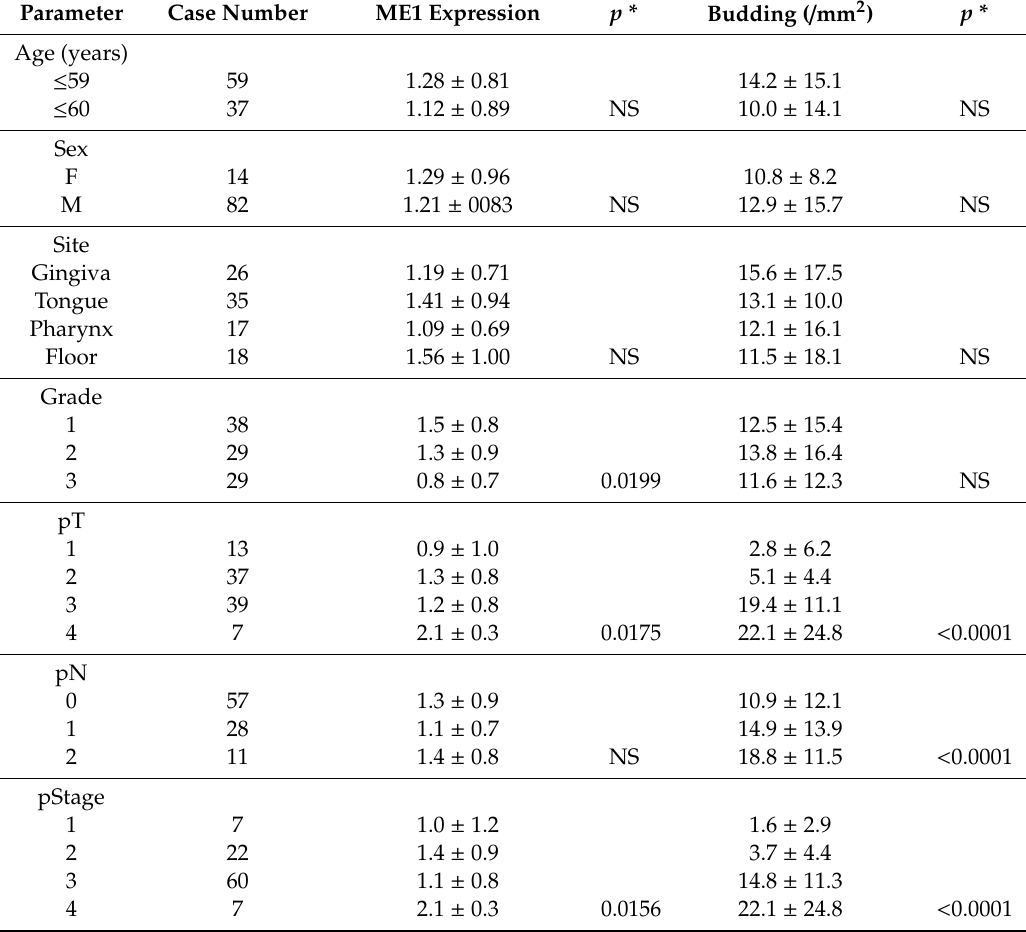
Figure 1. Relationship between tumor budding and malic enzyme)1 expression. ( A ) Tumor budding confirmed by AE1/AE3 immunostaining and ME1 immunoreactivity. Scale bar, 100 µm. ( B ) Correlation between tumor budding and ME1 expression by Spearman regression model. Spearman r = 0.284, p < 0.005. ME1, malic enzyme 1; AE1/AE3, cytokeratin AE1/AE3. Table 1. Relationship between ME1 expression or tumor budding and clinicopathological parameters in 96 oral squamous cell carcinomas.